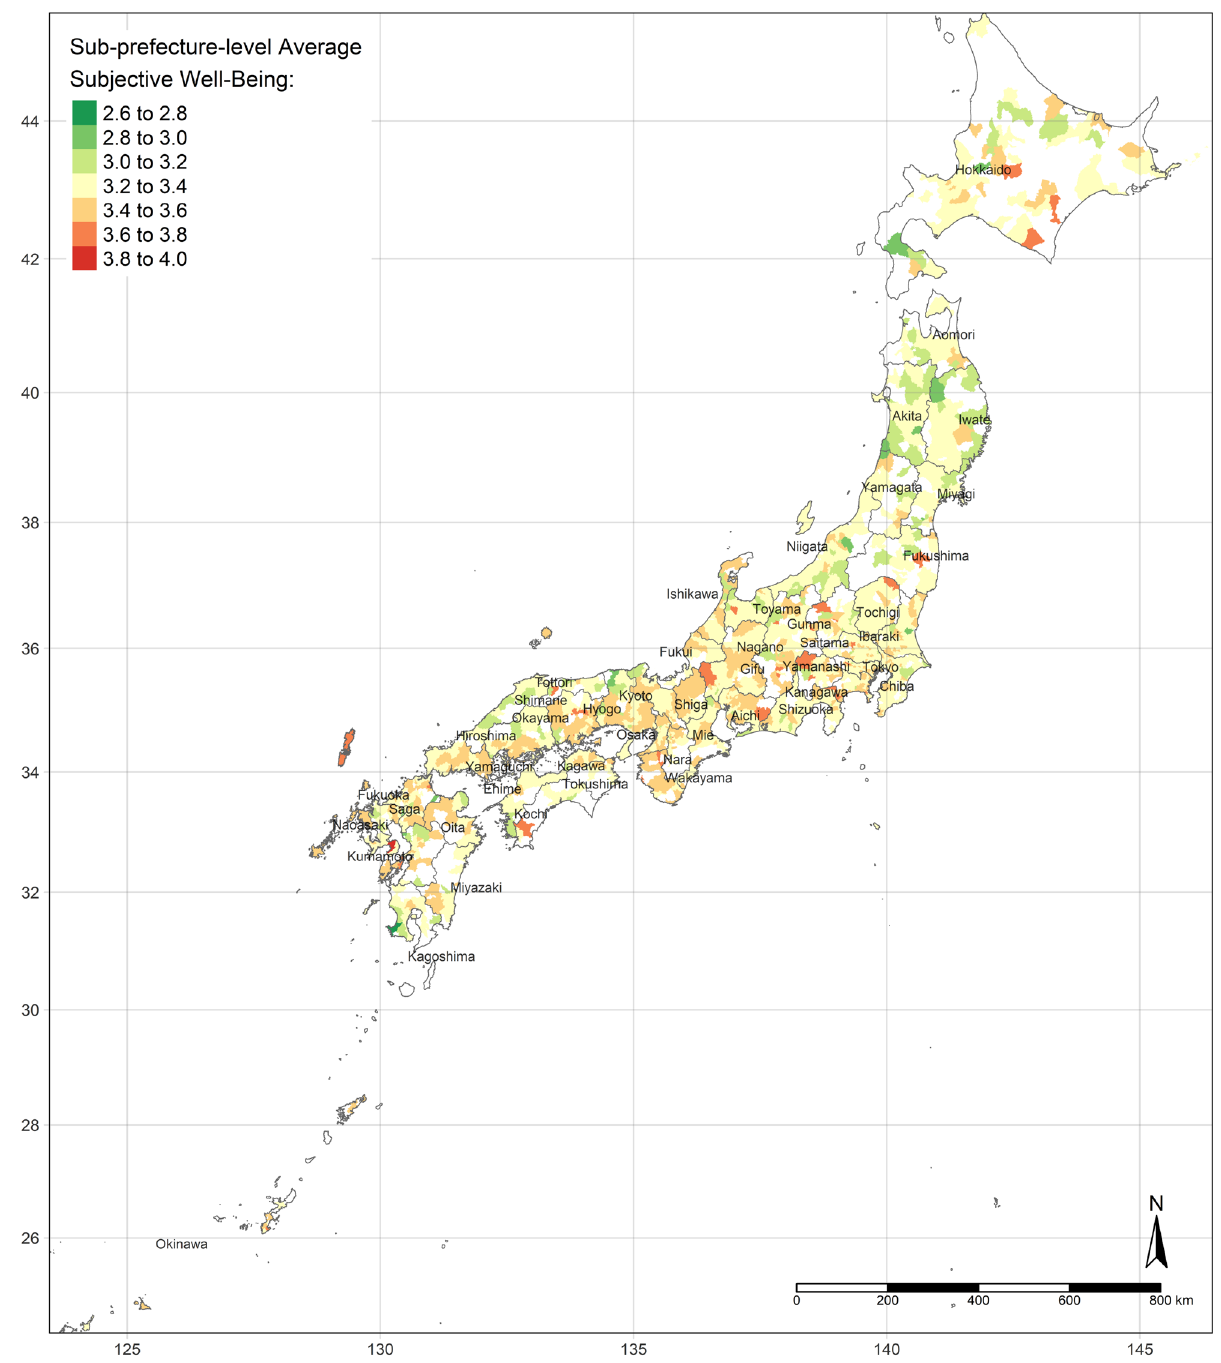
Figure 1. Sub-prefecture-level average SWB. (Figure is created by R 4.0.4, https:// cran.r- proje ct. org/ bin/ windo ws/ base/ old/4.